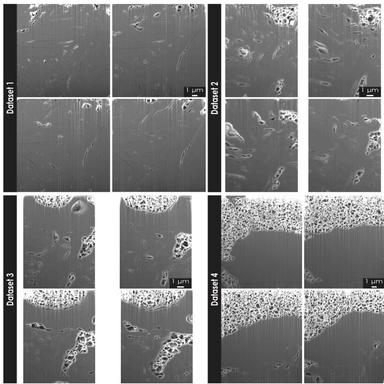
FIB-SEM tomography datasets of CGB graphite. Low-to-high carbon foam content in the same bulk sample of CGB graphite. These micrographs show that certain pores are not infiltrated by the carbon foam, but others are fully saturated by the material.